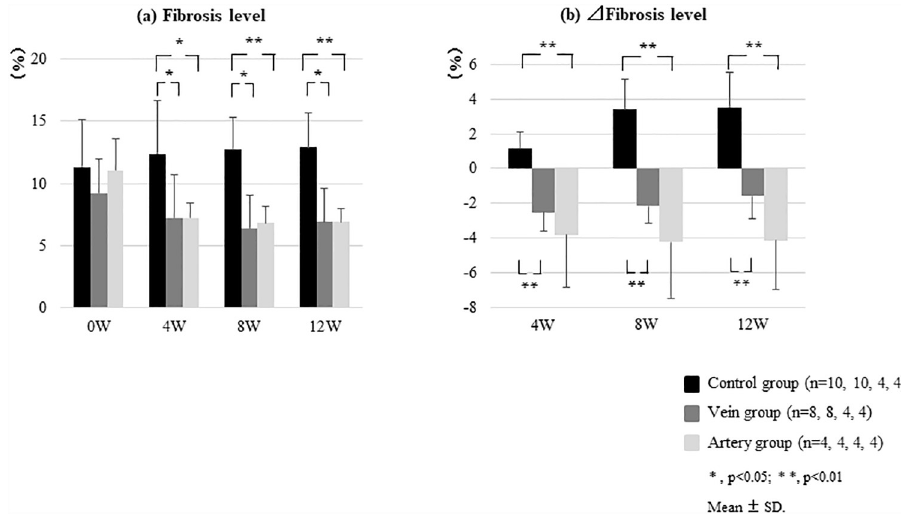
Fig 4. Quantification of liver fibrosis assessed by Sirius red staining in different treatment groups. The canines were administered repeated carbon tetrachloride (CCl 4 ) injections to induce liver fibrosis and treated with bone marrow-derived mesenchymal stem cells (BMSCs) via the peripheral vein (Vein group) or hepatic artery (Artery group). (a) Significant improvements in fibrosis level were found in both the Vein and Artery groups with respect to that in the Control group at 4, 8, and 12 weeks post-BMSC administration. (b) With respect to the change in ( Δ ) fibrotic area, a significant improvement in fibrosis was found at 4 weeks post-BMSC administration in the Vein ( Δ fibrotic area: − 2.5 ± 1.1%) and Artery groups ( − 3.8 ± 3.0%) relative to that in the Control group (+0.9 ± 1.0%). A greater effect was found in the Artery group, and this effect was maintained even after 8 ( − 4.3 ± 3.2%) and 12 ( − 4.2 ± 2.8%)